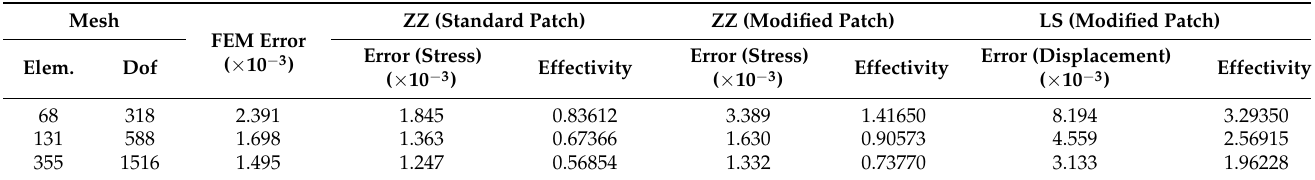
Table 8. Solution error and global effectivity for the plate with an opening problem using stress/displacement recovery and patch configuration (quadratic triangular element).